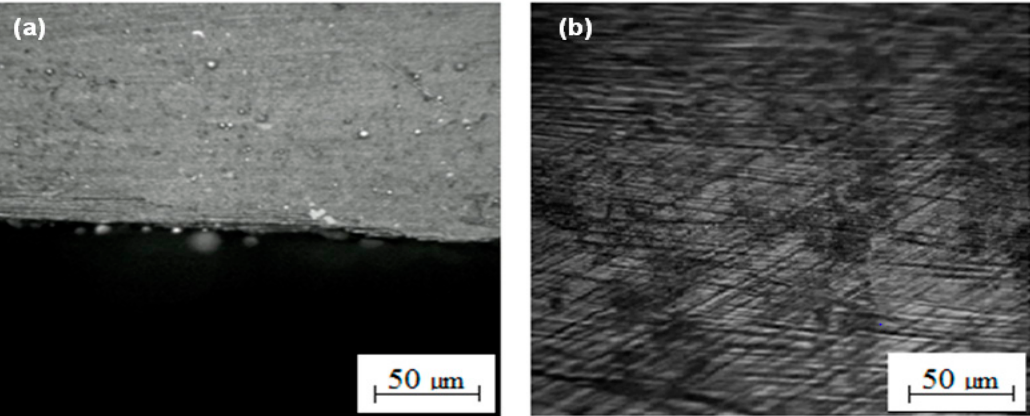
Figure 11. Machined PCM surfaces after application of a conductive Ti-layer on the surface of PCM; ( a )—sheet surface at the processing zone (at the edge), ( b )—along the cross-section of sheet width.